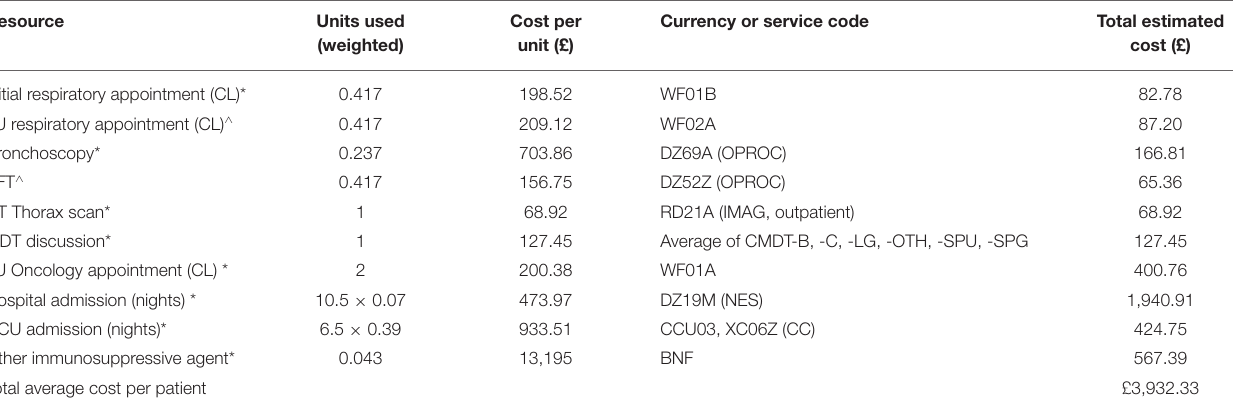
TABLE 4 | The estimated average per-patient cost of symptomatic pneumonitis based on NHS reference and BNF unit costs. Resource Units used